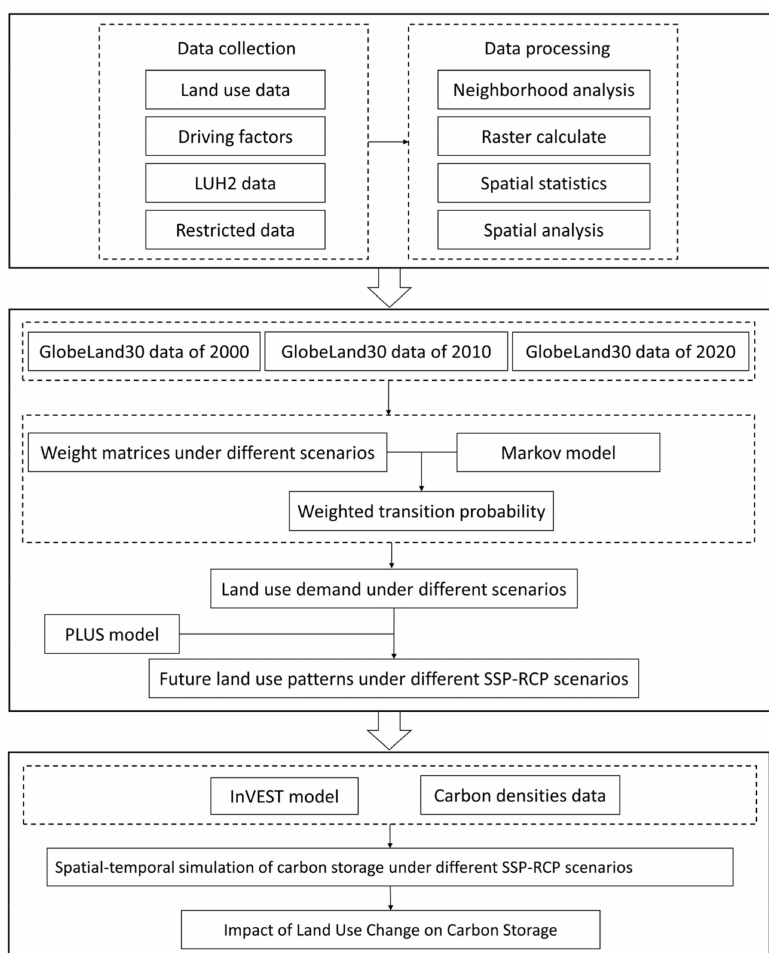
Figure 2. Methodological workflow employed in the